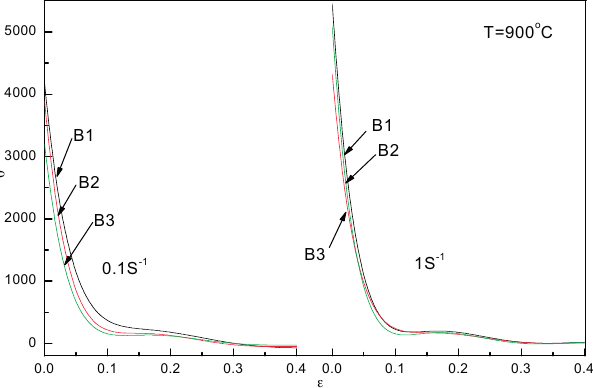
Figure 13. Strain dependence of the work-hardening rate for the experimental steels at 900 °C for strain rates of 0.1 and 1 s − 1